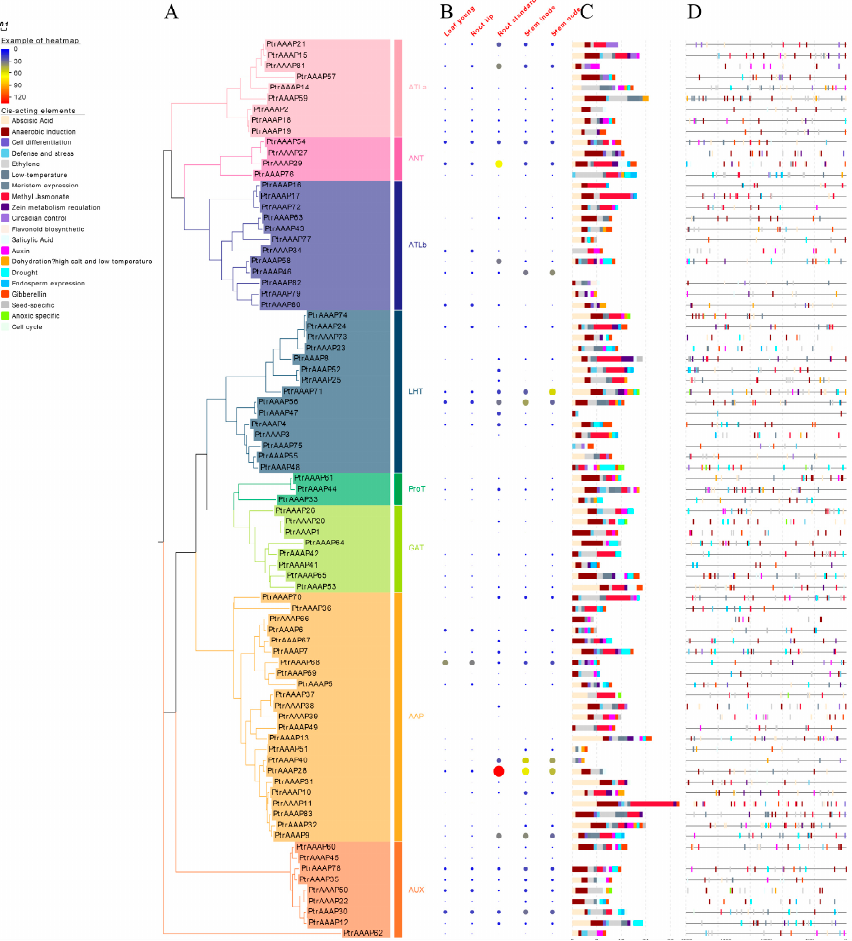
Figure 3. Phylogenetic tree of PtrAAAPs . ( A ) The name of each subfamily was marked on the outside of the phylogenetic tree. The PtrAAAPs were divided into ATLa, ANT, ATLb, LHT, ProT, GAT, AAP, and AUX 8 subfamilies. ( B ) The expression heatmap using phytozome online data. ( C ) Statistics of the cis-elements contained in the promoter region of each PtrAAAP . ( D ) Distribution of cis-elements of PtrAAAPs in chromosomes.